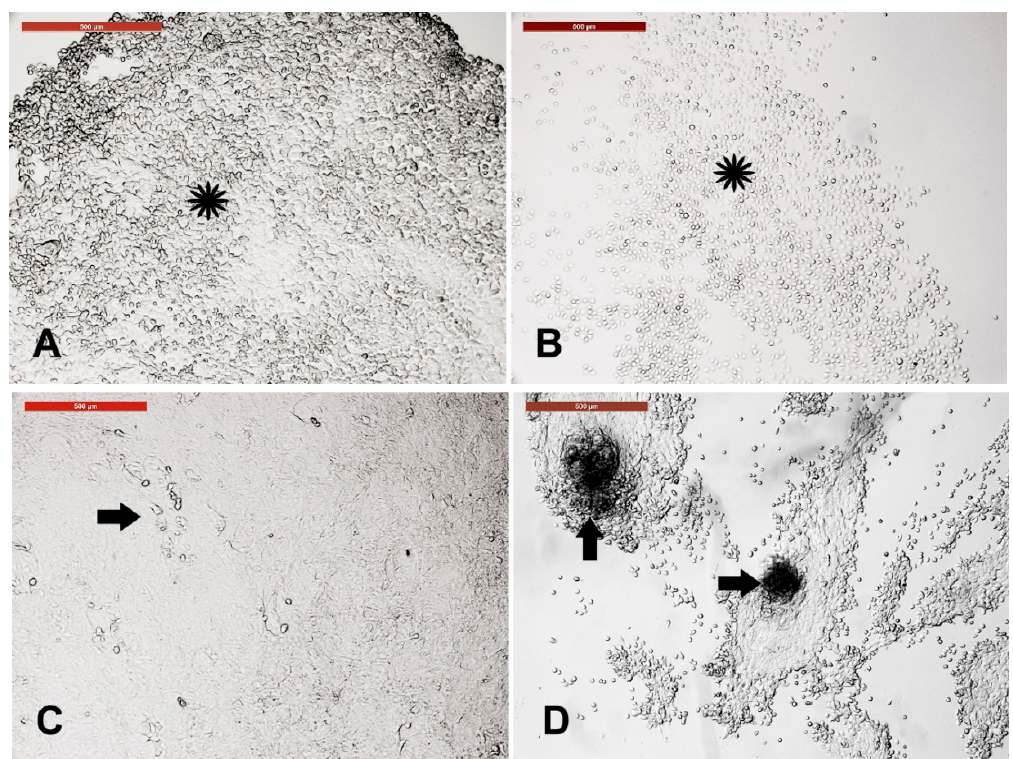
Figure 3. Sensitivity of different skin-derived cells to trypsinization. Incubation of primary cell culture with trypsin-EDTA for 5 min showed varied behavior. ( A ) Keratinocytes, the cell sheet, was distorted after 4.5 min (asterisk). ( B ) Fibroblasts, with round cells, were observed after 1.5 min of trypsinization (asterisk). ( C ) The fluid filled cyst layer showed resistance to trypsin for 5 min (arrow) indicating no change in cell morphology after trypsinization. ( D ) Cell clumps (spheroids) showed resistance to trypsin and the surrounding cells (arrows). Scale bar = 500 µm.